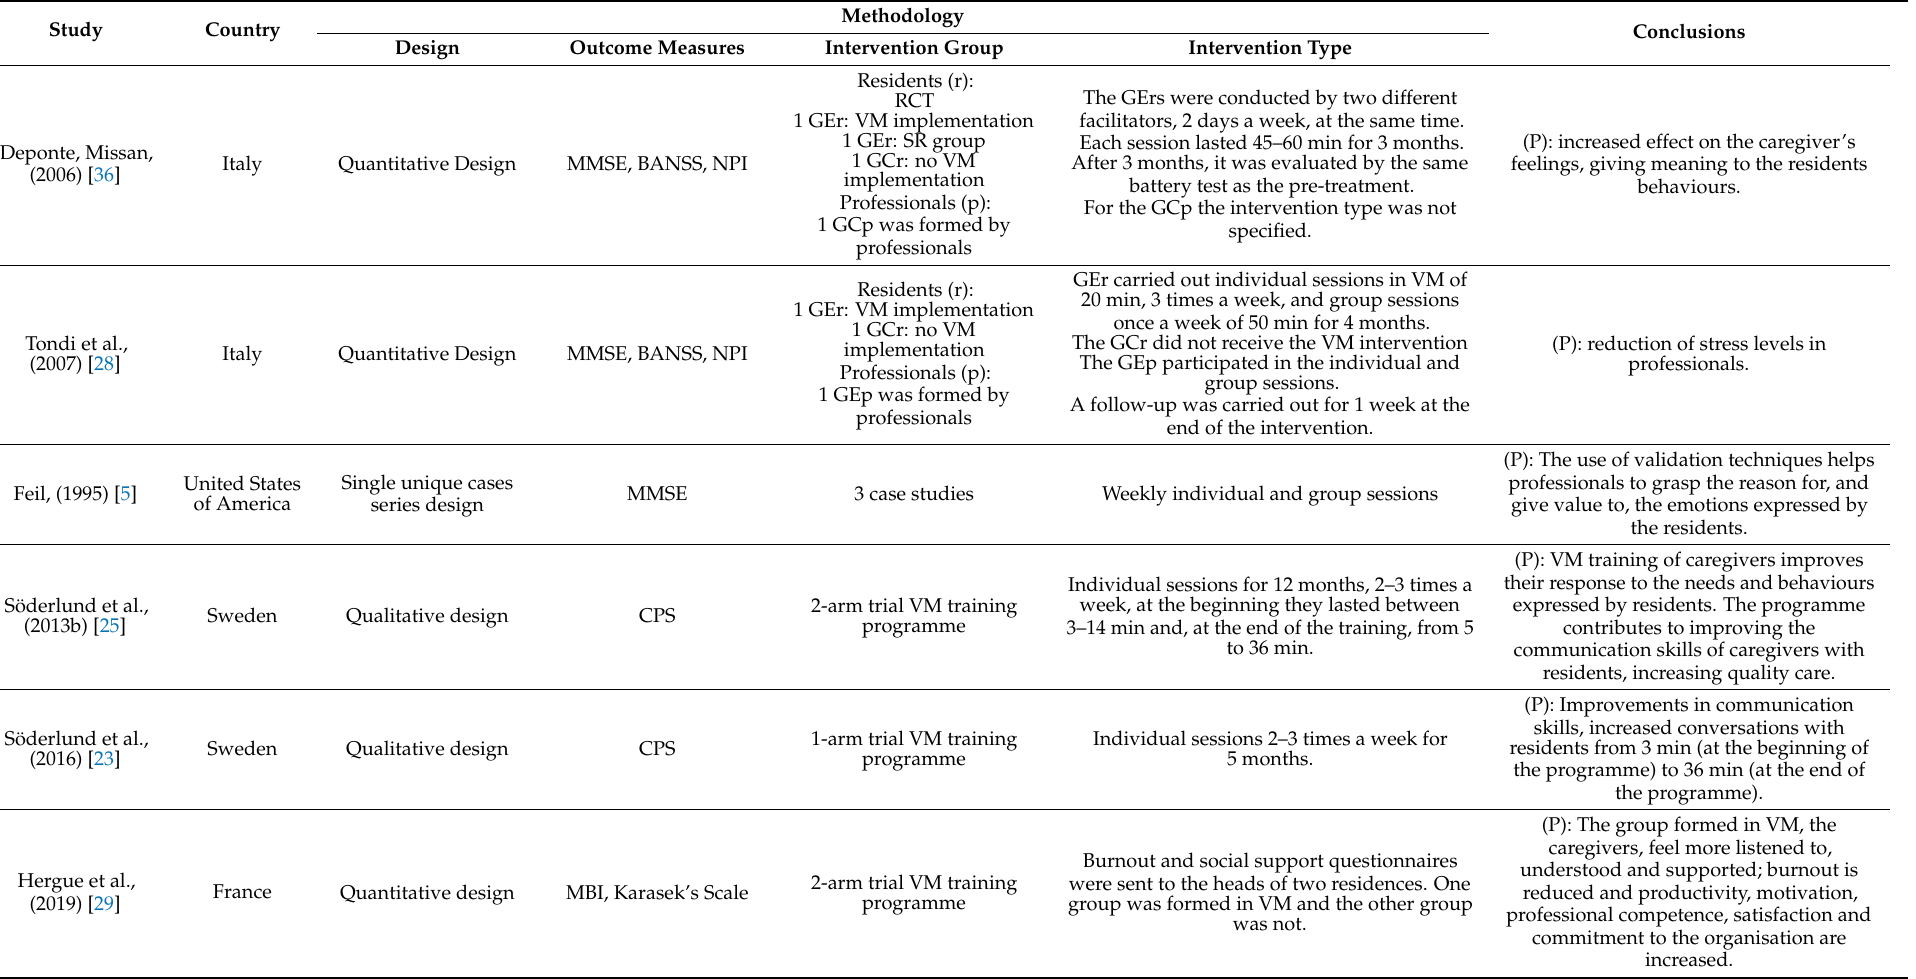
Table 3. Included studies on the effect of the implementation of VM in nursing home care